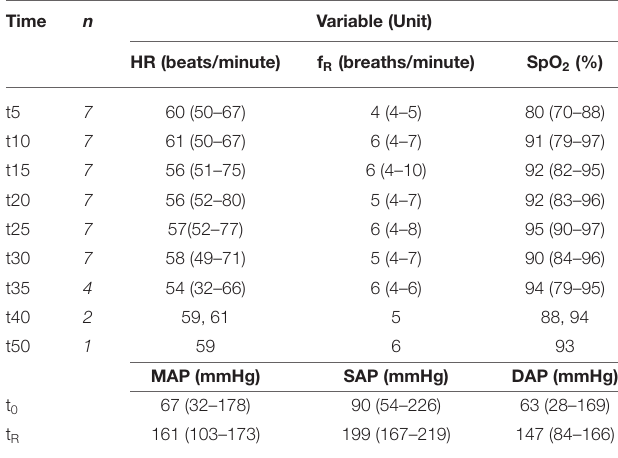
TABLE 1 | Heart rate (HR), respiratory rate (f R ) and partial pressure of oxygen (SpO 2 ) measured by pulse oximetry from the first measurement (t5) until maximum 50 mins (t50) and non-invasive oscillometric mean arterial (MAP), systolic (SAP) and diastolic (DAP) blood pressures at first handling (t0) and at reversal (t R ). Time